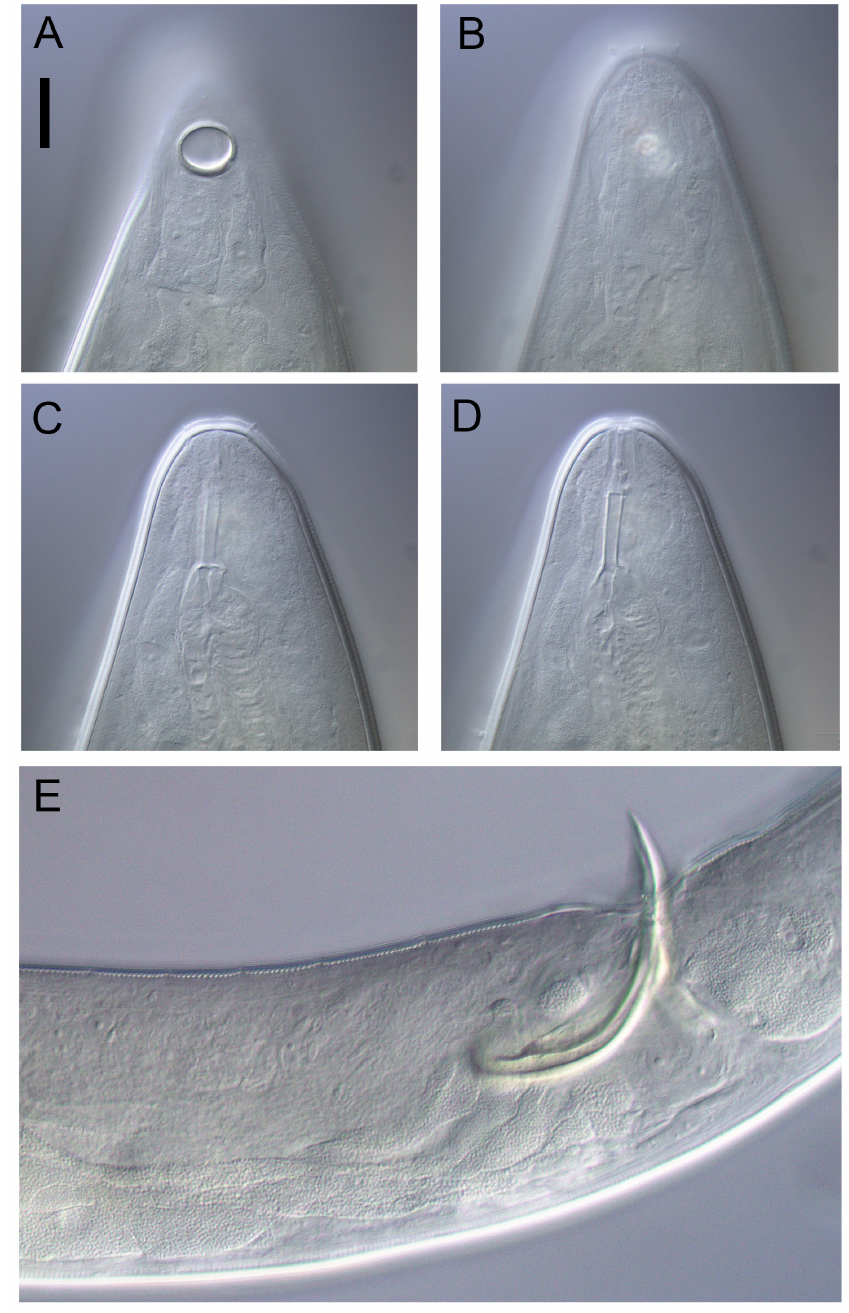
Fig. 8. Aulostomonema abyssum gen. et sp. nov. Light micrographs of male, holotype (NIWA154911). A . Cephalic region showing amphid. B . Cephalic region showing anterior sensilla. C . Cephalic region showing pharynx. D . Cephalic region showing buccal cavity. E . Copulatory apparatus and precloacal supplements. Scale bar: A–D = 20 µm; E = 18